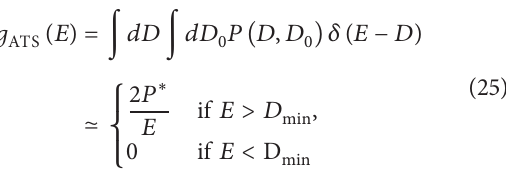
Figure 11: (Color online) A cartoon of the fractal (presumably percolating) geometry of the NM-pockets and channels (green); these NM- clusters grow with increasing 𝑥